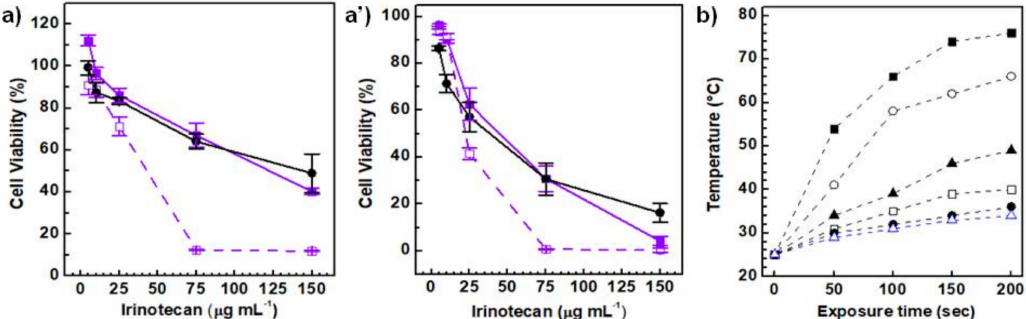
Figure 7. Anticancer activity on MDA-MB-231 after 24 h and 48 h of incubation ( a , a’ ): irinotecan (dark solid line, close circle), PLGA-CDs20%@IT NPs (violet solid line, solid square), PLGA-CDs20% NPs + laser (violet dash line, open square). Photothermal e ff ect of the PLGA-CDs20% NPs dispersion in DMEM at di ff erent concentration ranging from 5 to 150 µ g mL − 1 . DMEM was used as control (blue open triangle) ( b